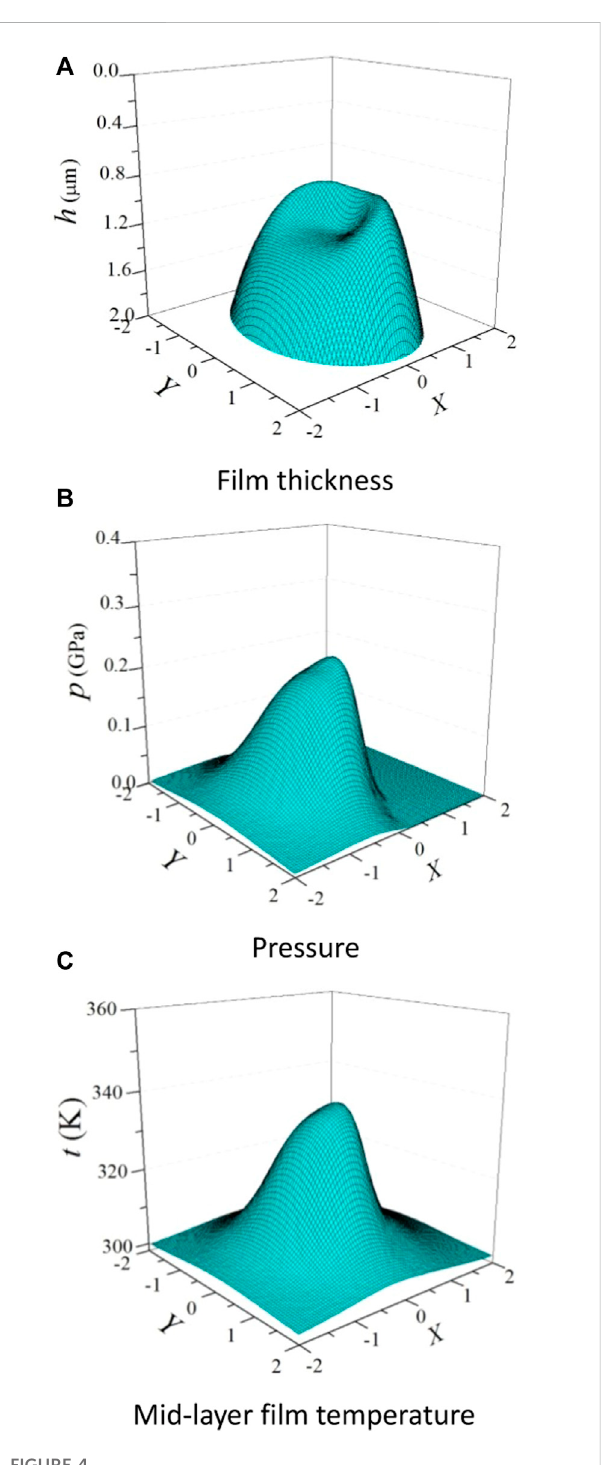
FIGURE 4 Typical numericalsolutionsforthetaperedribfor R x 2 / R x 1 =0.3, w = 320 N,and n i =1,000r/min. (A) Filmthickness, (B) pressure,and (C) mid- layer fi lm temperature.